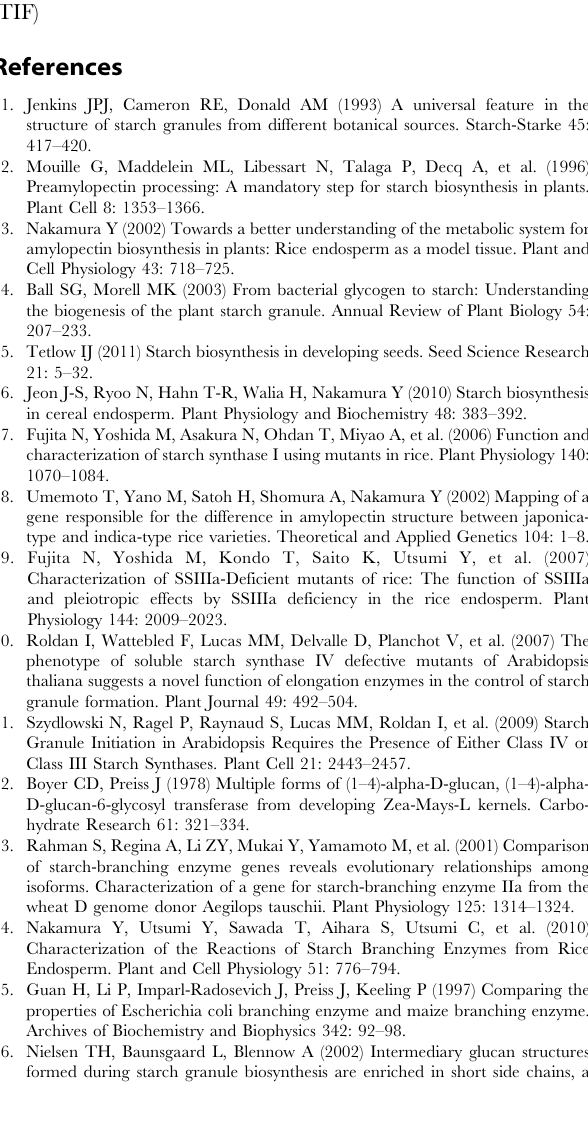
Figure S8 Preliminary fitting (green circles) to the CLD described in Figure S7 (yellow circles). The fitting is generated with some initial guesses of the fitting parameters. (TIF) Figure S9 Optimized fitting to the single-lamella range (DP # 30) of the CLD in Figure S8. (TIF) Figure S10 Optimized fitting to the trans-lamella range (DP . 30) of the CLD in Figure S9. (TIF) Figure S11 Optimized fitting (green circles) to a typical amylopectin CLD (yellow circles) obtained by SEC.